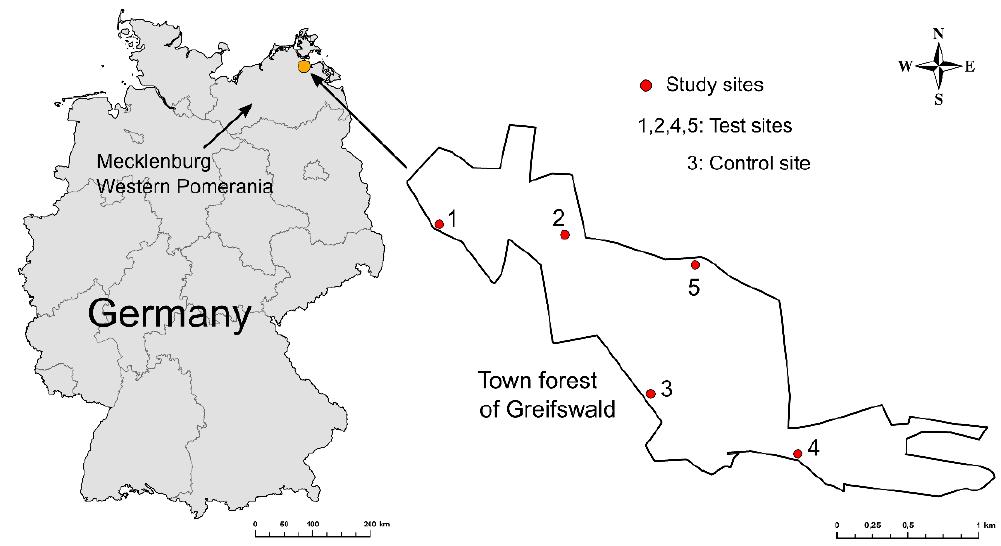
Figure 1. Location of the study sites in the city forest outside the town of Greifswald/Germany.